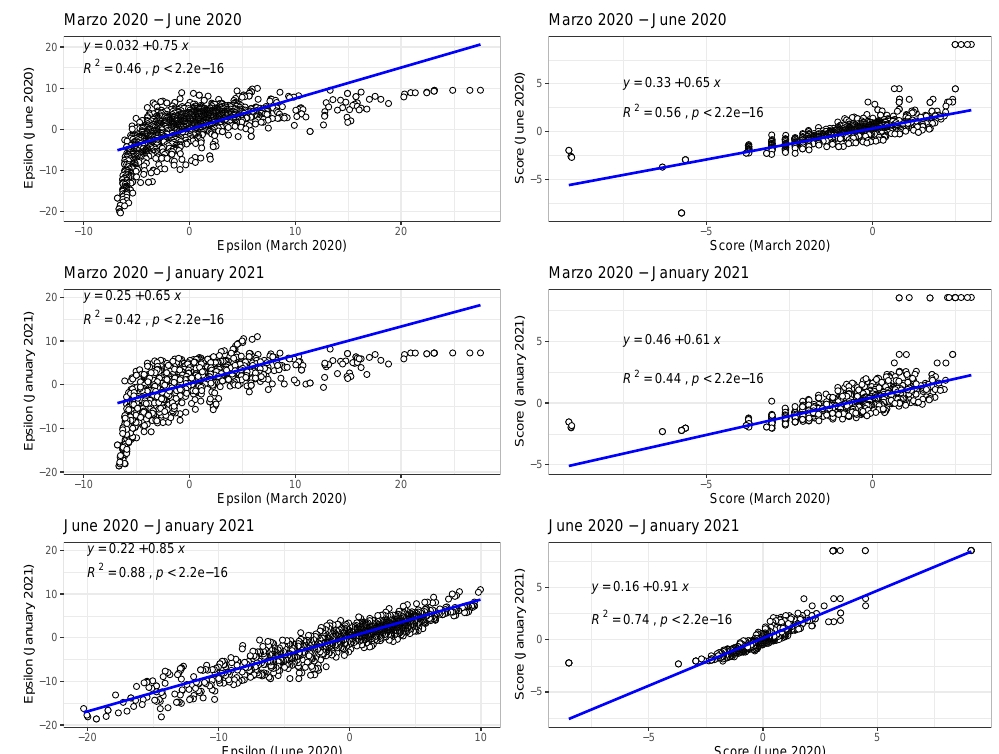
( t )) values for all habitat variables for the model for the Figure 5. Left: Correlations between ε ( X m i presence of COVID-19 cases for two different months; Right: Correlations between s ( X m for all habitat variables for the model for the presence of COVID-19 cases for two different